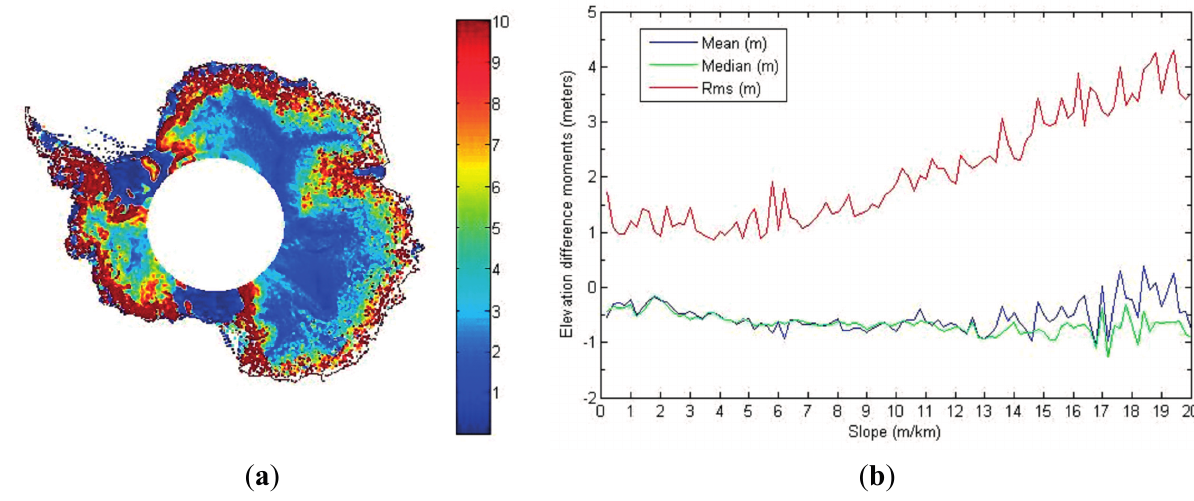
Figure 1. ( a , b ) Focus on the slope correction and why we do not keep the high-sloped areas in our data analysis: mean slope at crossover points for ENVISAT and ICESat in m/km after the slope correction. (a) We observe the poorer sampling over the coasts and within the Peninsula area; (b) spatio-temporal mean, median and std of the elevation difference between ICESat and ENVISAT in meters depending on the slope